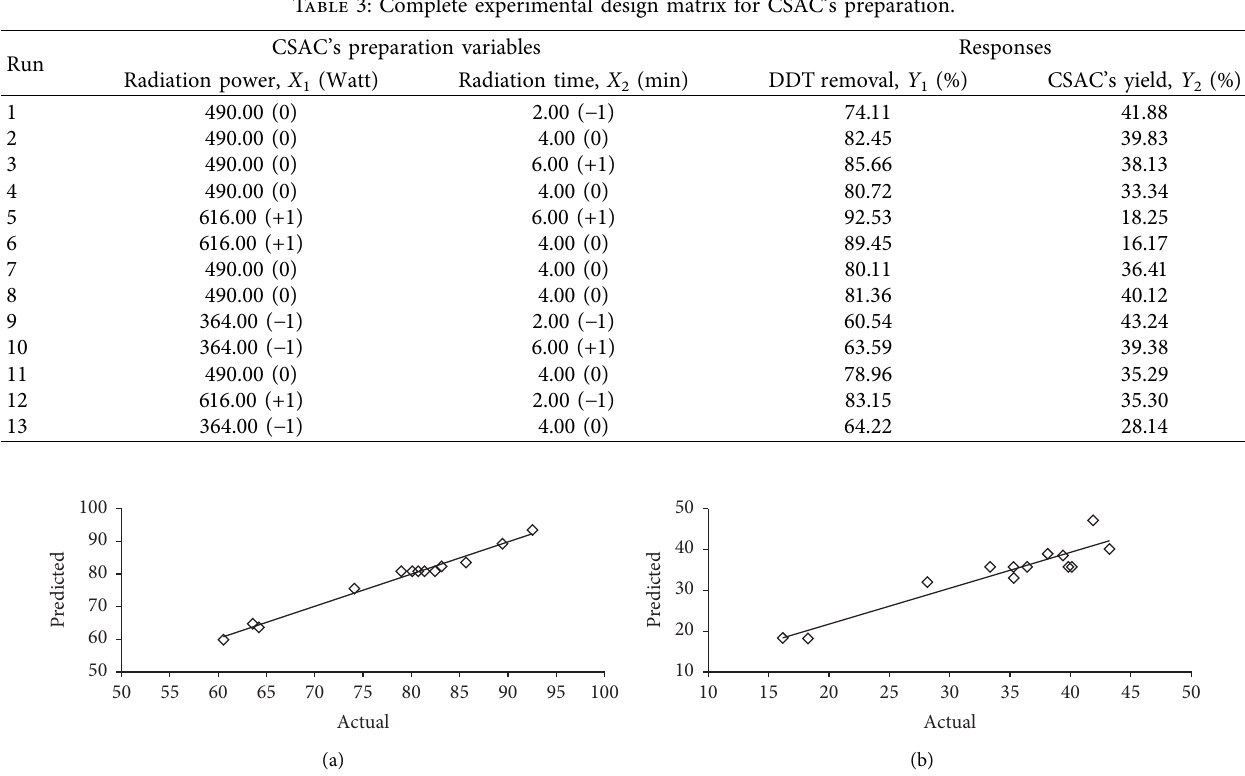
Table 3: Complete experimental design matrix for CSAC’s preparation.